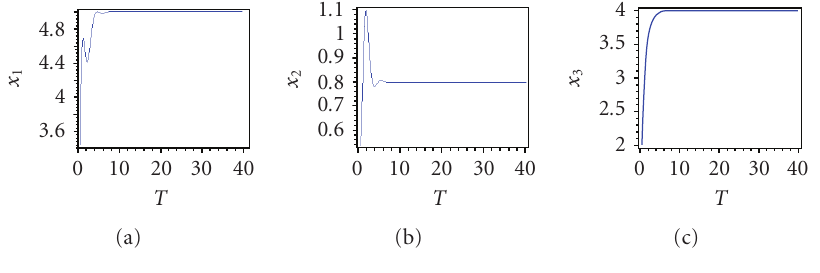
Figure 5.3. Time series of the system (5.1), p = 4 . 5, q = 4, T = 0 .